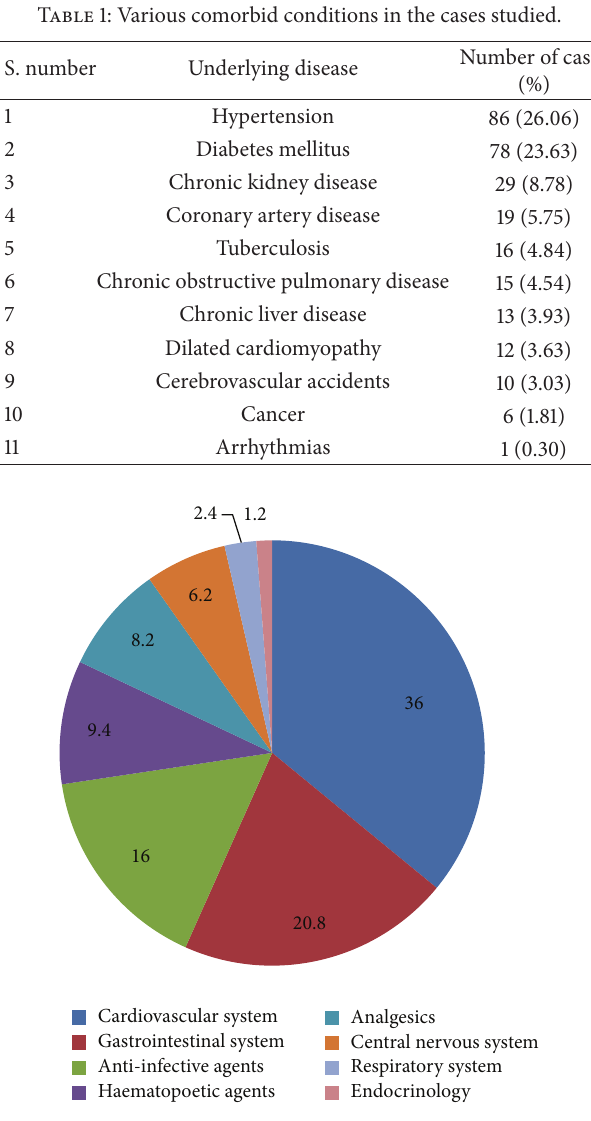
Figure 2: Pie chart showing various classes of drugs prescribed.